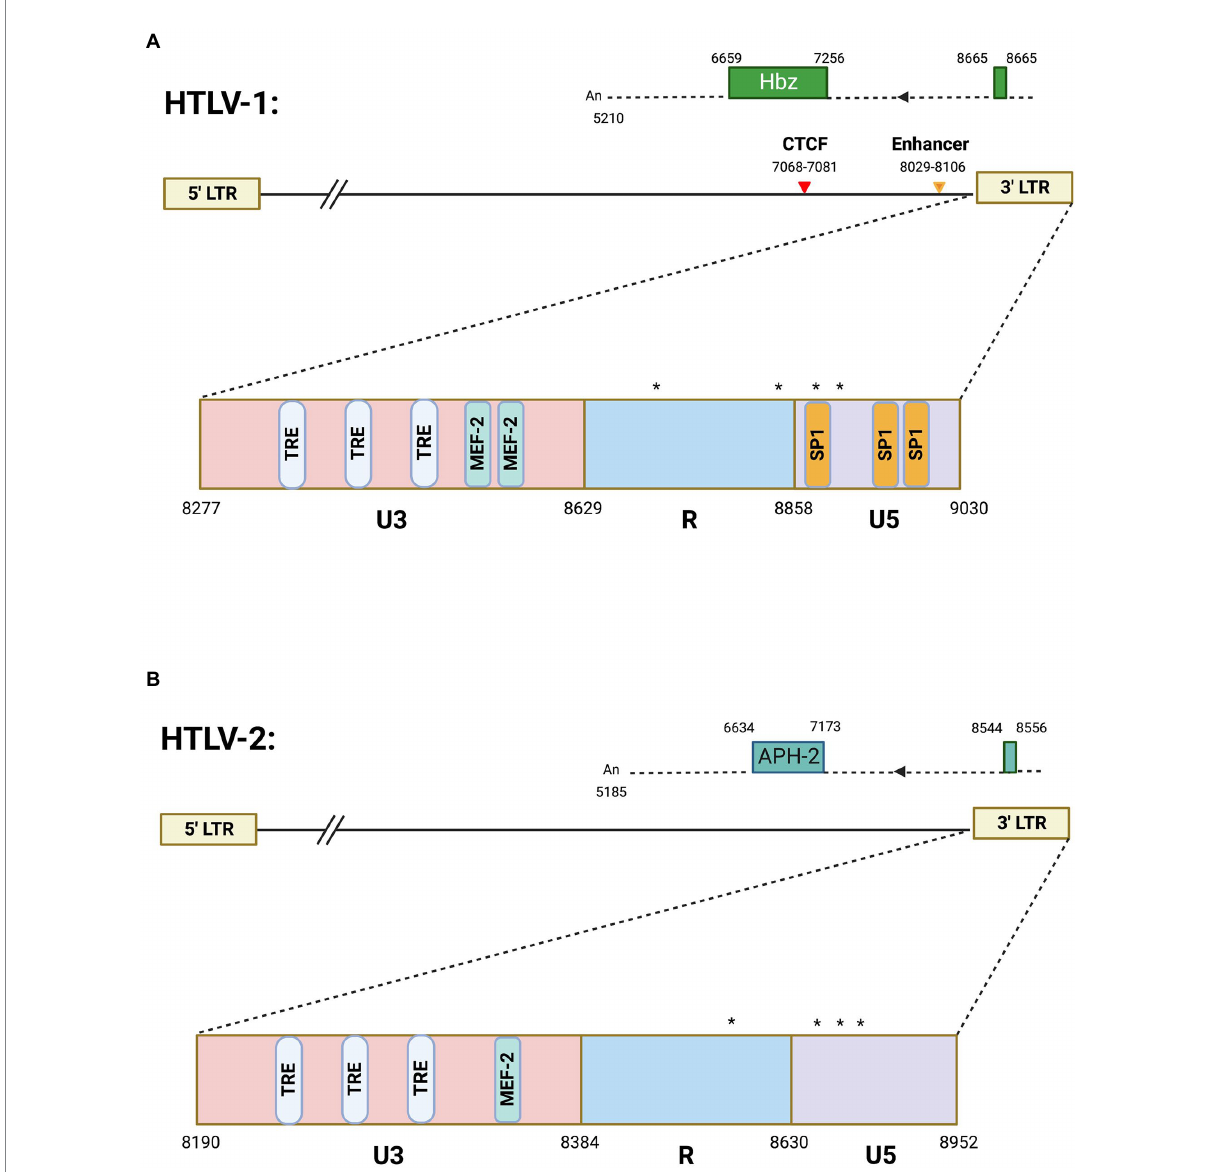
FIGURE 1 Antisense transcription in HTLV-1 and HTLV-2. Schematics of (A) HTLV-1 and (B) HTLV-2 proviral genomes highlighting the 3 ′ LTR region. The HTLV-1 3 ′ LTR contains two MEF-2 binding sites (published previously in Jain et al., 2015), several Tax responsive elements (TREs), and SP1 binding sites. Also depicted are the vCTCF binding site and Enhancer region, which overlap with the HBZ coding sequence and hbz intron, respectively. Spliced HBZ and APH-2 open reading frames are depicted above each proviral genome. In contrast, the HTLV-2 3 ′ LTR is approximately 53% identical (by sequence alignment) and contains predicted TREs and 1 potential MEF-2 binding site. Drawing is intended to be illustrative and not to exact scale. Nucleotide positions are derived from the HTLV-1 (ACH) and HTLV-2 (pH6) molecular clones. (*) denote transcription start sites. Frequently used transcription initiation sites have been identified at positions 8702, 8854, 8876, and 8882 in HTLV-1 and positions 8578,